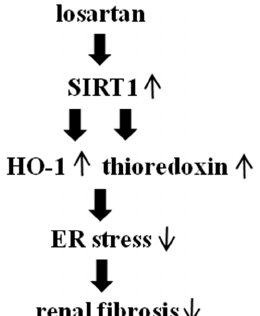
Figure 9. Proposed signaling pathways involved in anti-fibrotic effect of losartan. ↑ represents up-regulation; ↓ represents down-regulation.